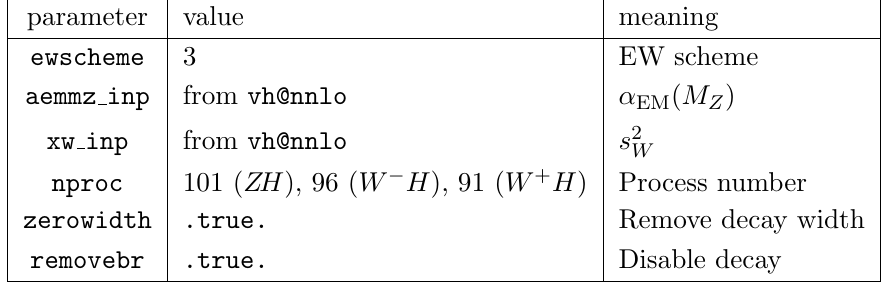
Table 23 . Input parameters for MCFM set in vh@nnlo